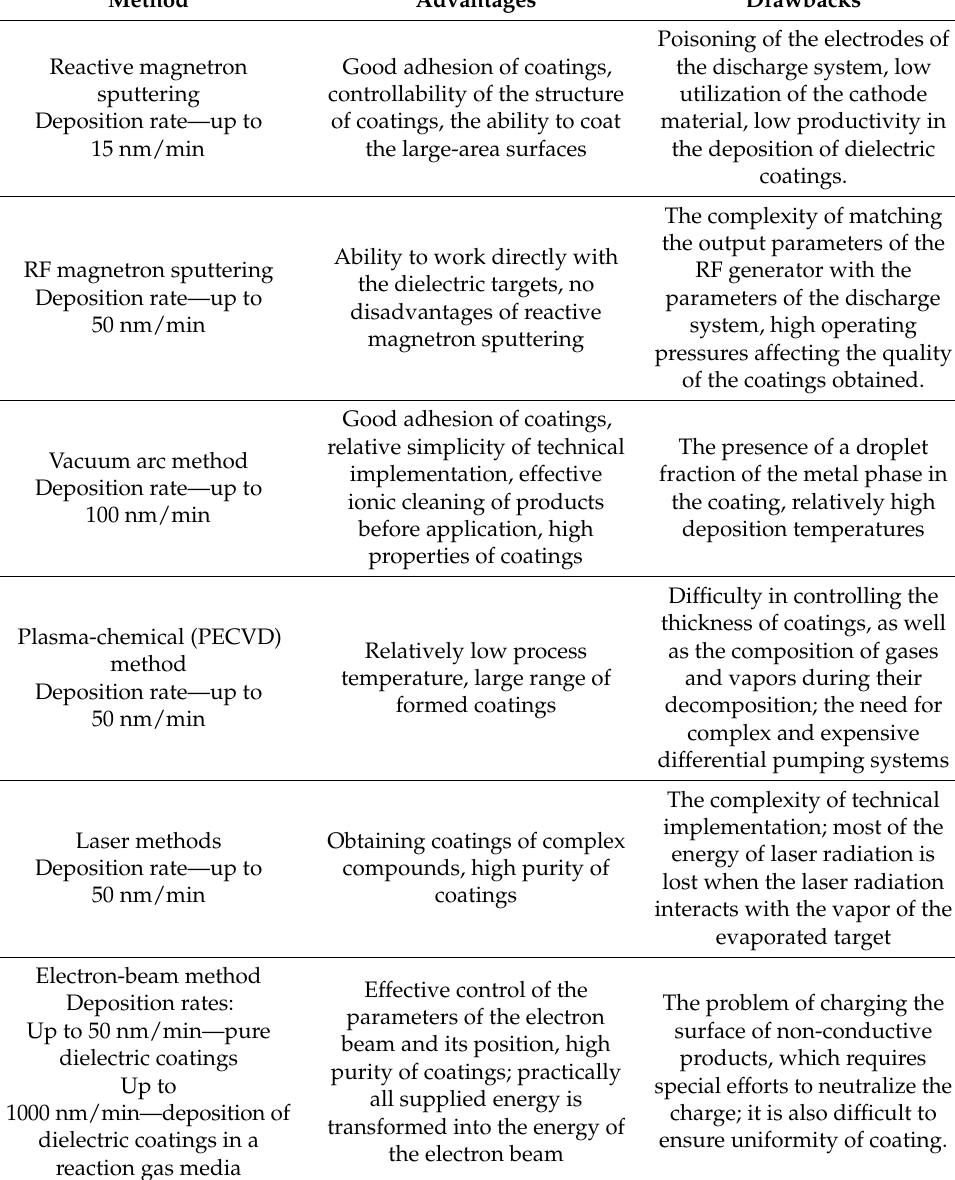
Table 2. Comparison of different coating deposition